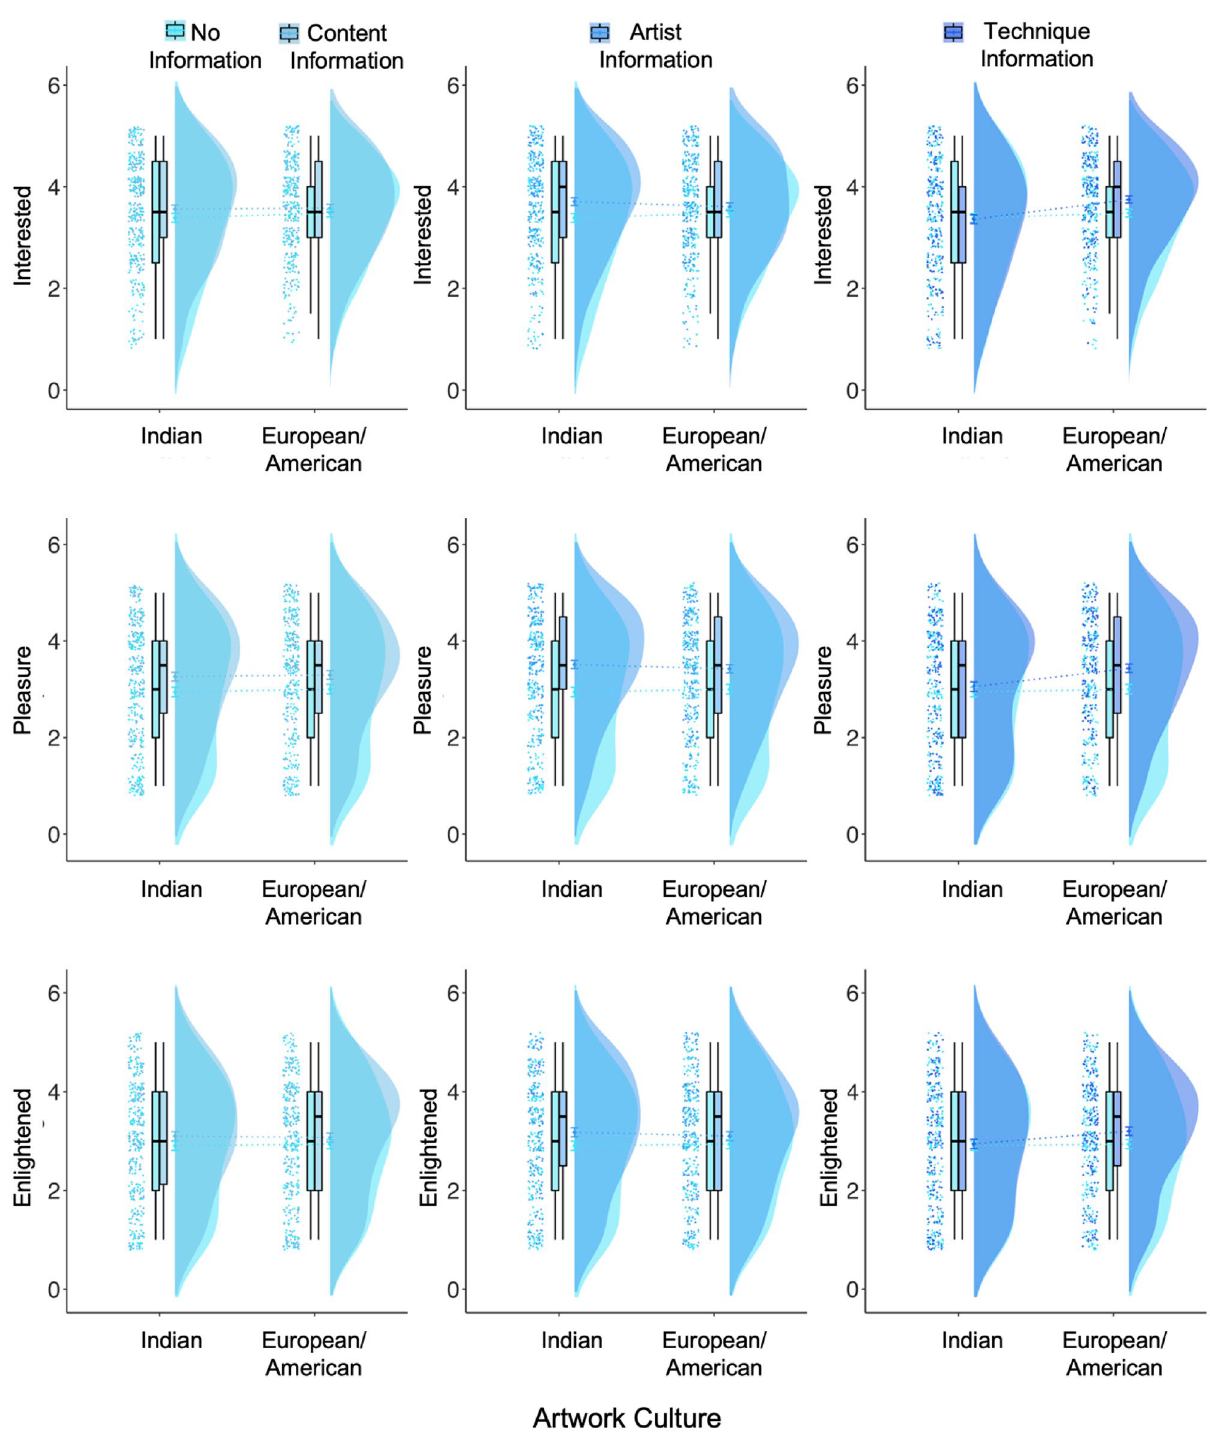
Figure 10. Ratings of how much pleasure, and how interested and enlightened participants felt by Indian and European/American artworks when content information (on the left), artist information (in the centre), and technique information (on the right) are provided to participants compared to no